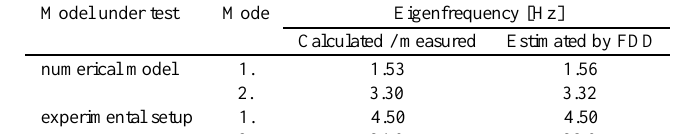
Table 1 Measured / calculated and estimated eigenfrequencies